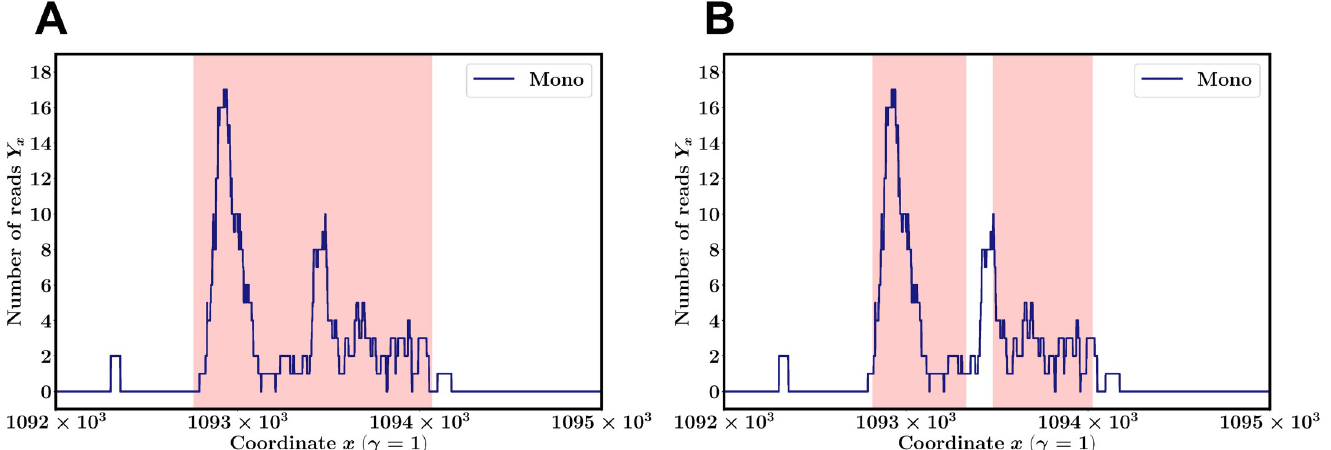
Fig 1. The number of reads vs genomic positions. The plots show representative data of Mono obtained from SRA with accession number SRR2920475. (A) The number of reads Y at each position x along chr 1 ( γ = 1) and the peak region ( α x (pink shaded regions) is shown. The peak region and its associated p -value (( α k , β k ), p k ) are (1092756, 1094068, 10 − 20.36428 ). (B) The obtained peak regions are ((1092817, 1093330), 10 − 20.36428 ) and ((1093480, 1094025), 10 − 8.19447 ) for p